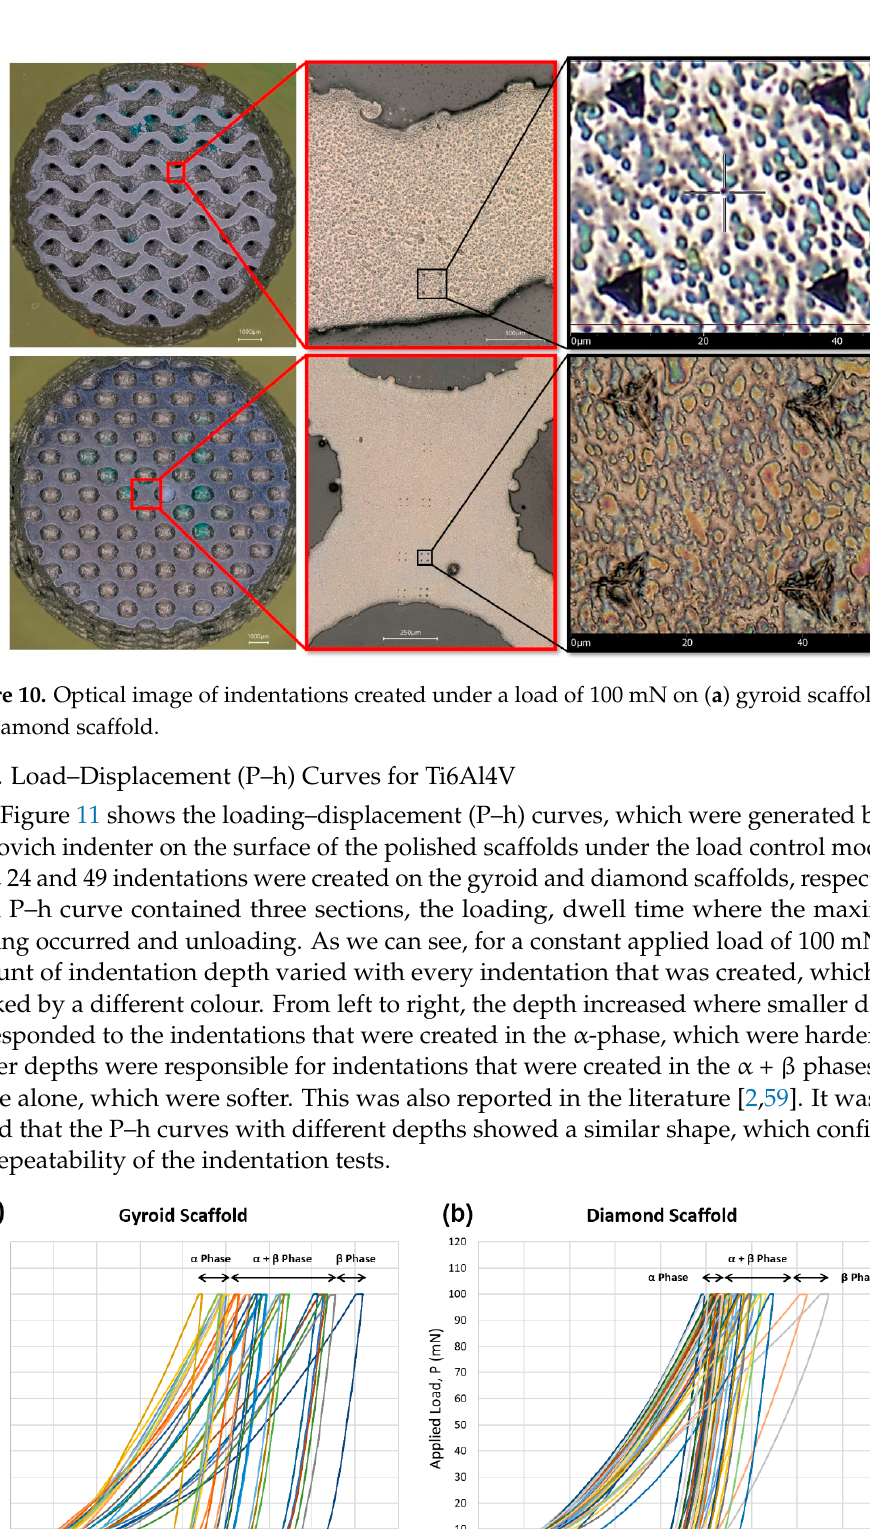
Figure 11. Indentation loading–unloading curves (or P–h curves) performed at 100 mN on ( a ) gyroid scaffold and ( b ) diamond scaffold. Different colours of the curves show different indentation loading–unloading that were performed on the gyroid and the diamond scaffold.